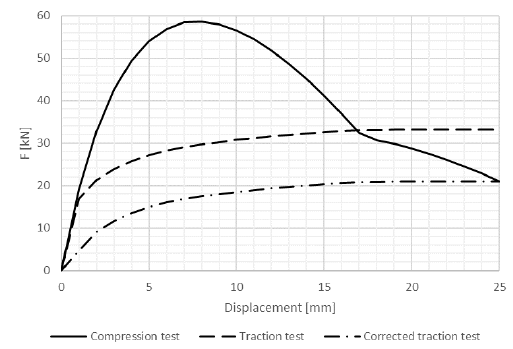
Figure 2. Graphs of the course of loading tests of a